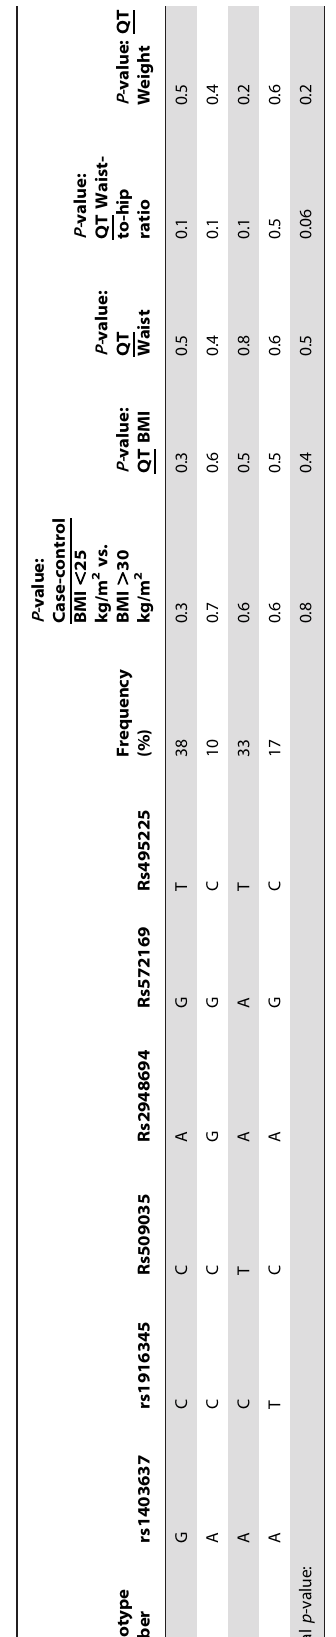
compared to a wild type showed an increased transcriptional activity measured as renilla-controlled luciferase activity in constructs expressing the 643 nucleotides upstream of the translation initiation site (Figure 3). In silico analyses predicted a change in the binding of several transcription factors including the introduction of a Sp1-like binding site caused by the introduction of the -151 variant. Electro-mobility shift assays (EMSAs) showed that the -151T mutant sequence created a high affinity binding site for a nuclear complex displaced by anti-Sp1 antibody and by competition with an Sp1 consensus oligonucleotides (Figure 4). Displacement of the labelled mutant probe was not observed with an unrelated antiserum or unlabeled Egr1 and Ets1 probes (data not shown).